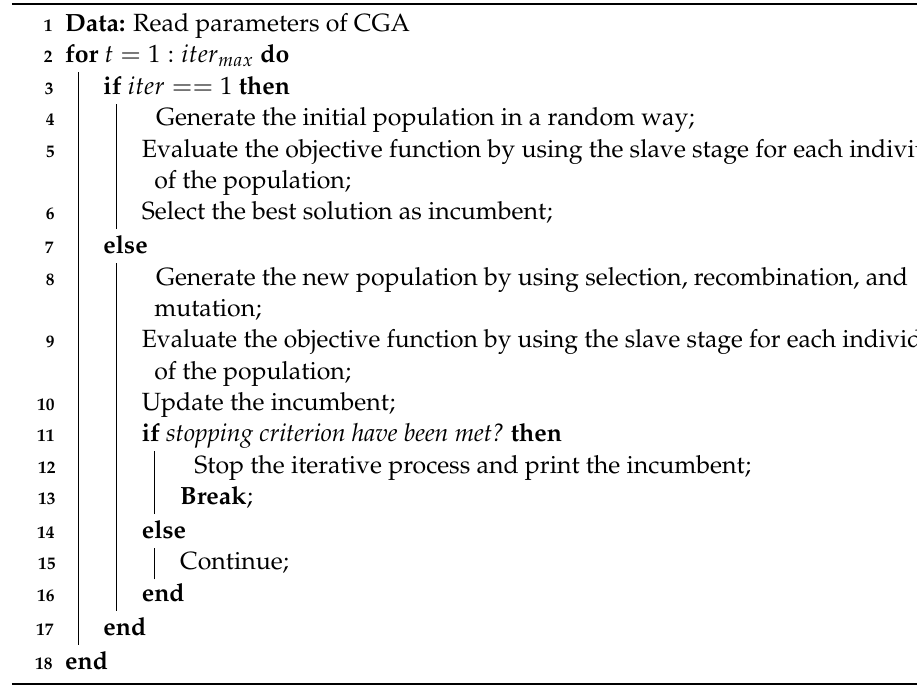
Algorithm 2 Algorithm proposed for the master–slave methodology based on the